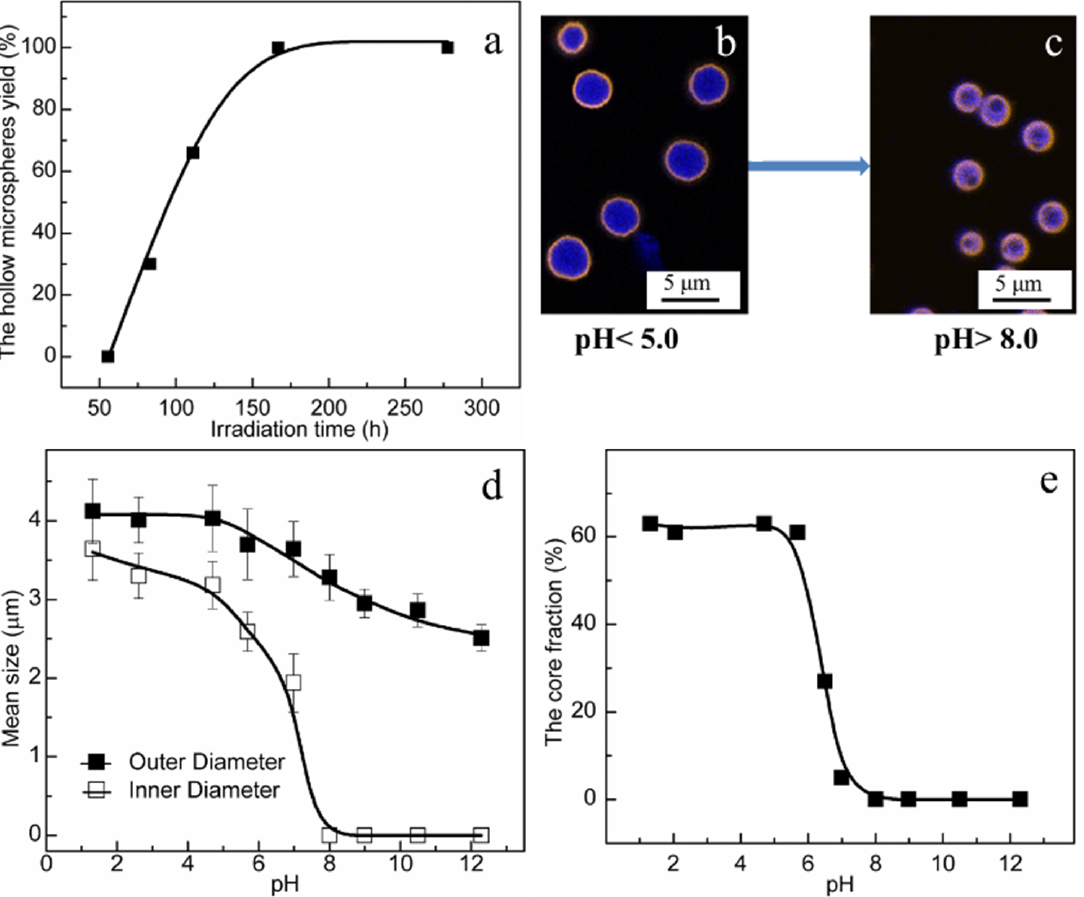
Figure 2. The relationship between the yield of hollow microspheres and irradiation time ( a ), the CLSM image of the hollow polymeric microspheres prepared by irradiating DCH18C6 aqueous solution for 167 h at pH < 5 ( b ) and pH > 8 ( c ), and the change in mean size ( d ) and core fraction ( e ) with pH for the hollow microspheres measured by CLSM.